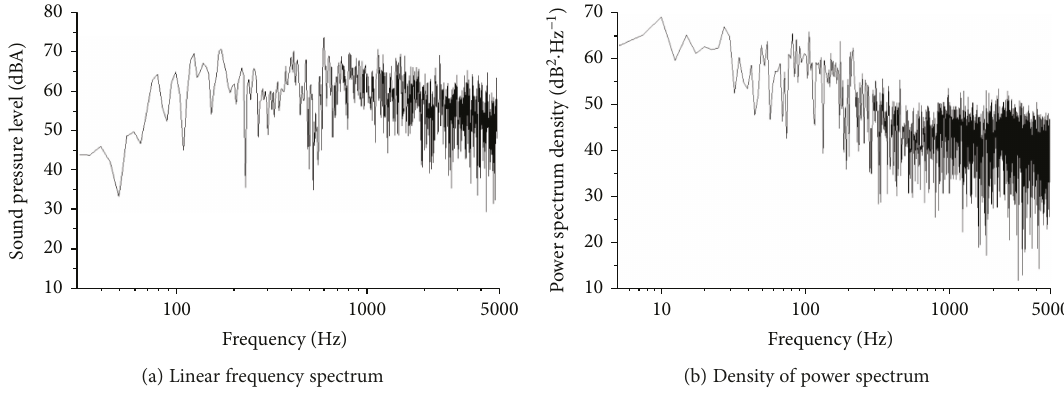
Figure 16: Aerodynamic noise spectrum of high-speed railways on